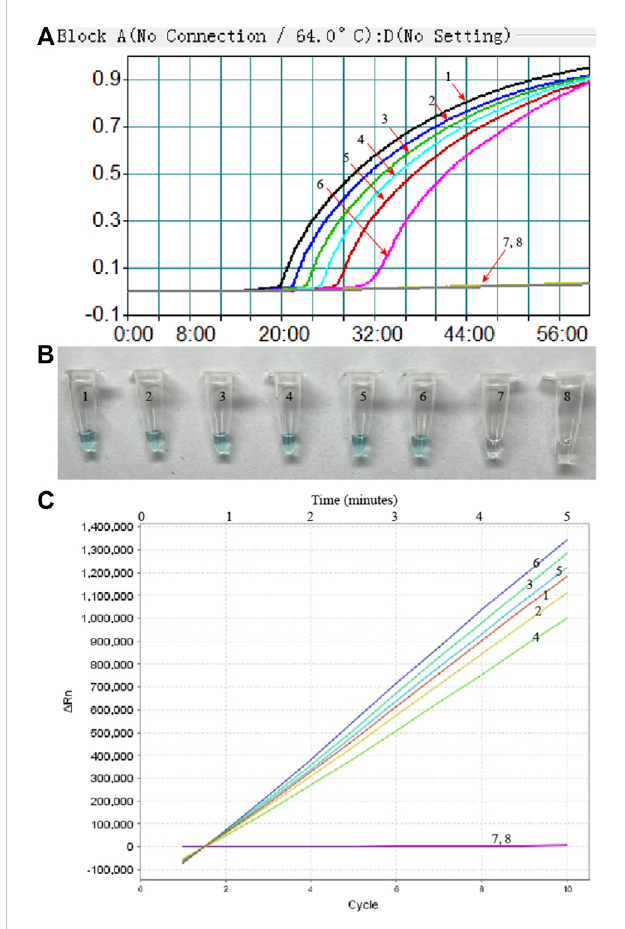
The sensitivity of the MP-MCDA-CRISPR assay. Real-time turbidity (A) , VDR (B) and RTF (C) methods were used to report the MP-MCDA- CRISPR assay results, respectively. Curves/Tubes 1 – 8 represent the MP genomic DNA concentrations of 5 ng, 500 pg, 50 pg, 5 pg, 500 fg, 50 fg,and5 fgperreaction,andtheblankcontrol(DW),respectively.The LoD of the MP-MCDA-CRISPR assay was 50 fg per